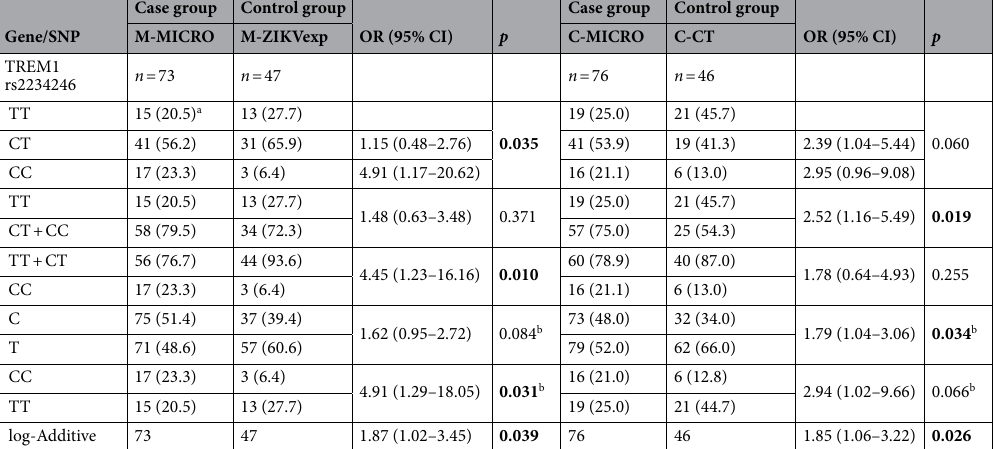
Table 3. Genotype and allelic frequency and distribution of TREM1 rs2234246 SNP and its association with CZS. M-MICRO, women who gave birth to infants with congenital Zika syndrome; M-ZIKVexp, mothers who living in ZIKV’s endemic areas who gave birth to healthy infants; C-MICRO, children with congenital Zika syndrome; C-CT, healthy children who were born of the mothers who living in ZIKV’s endemic areas. Bold indicates statistically significant. a (%) number of the subjects with the specified allele or genotype. Results of univariate logistic regression models and b Fisher’s exact